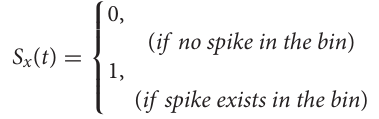
distribution curve with the plot of its own radius of